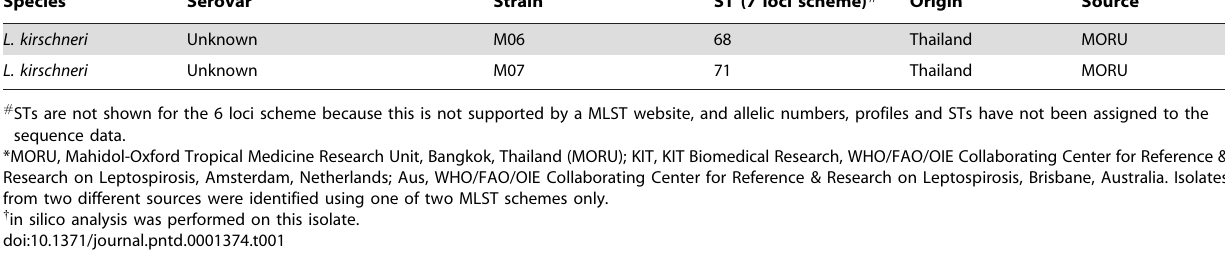
(Table 3). The diversity within L. interrogans was lower than that within L. kirschneri (0.5% and 1.1% for 7L, and 0.4% and 0.8% for